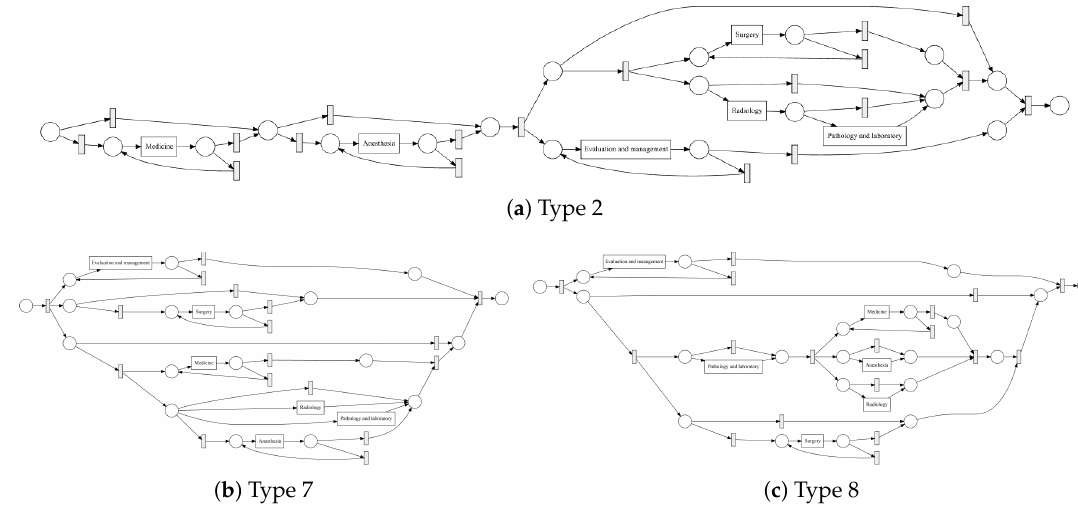
Figure 4. Discovered process models for cancer types 2, 7, and 8 in MIMIC.